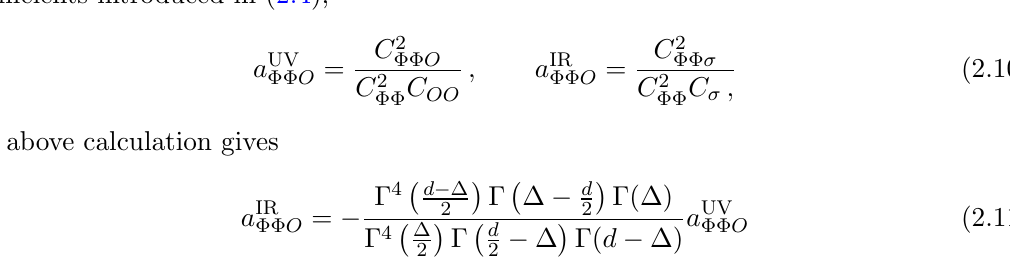
Figure 2 . The triangle diagram determines the three-point coupling h (cid:8)(cid:8) (cid:27) i , to which the UV coupling h (cid:8)(cid:8) O i (cid:13)ows. The purple point is integrated over. The factor in parenthesis is the OPE coe(cid:14)cient C